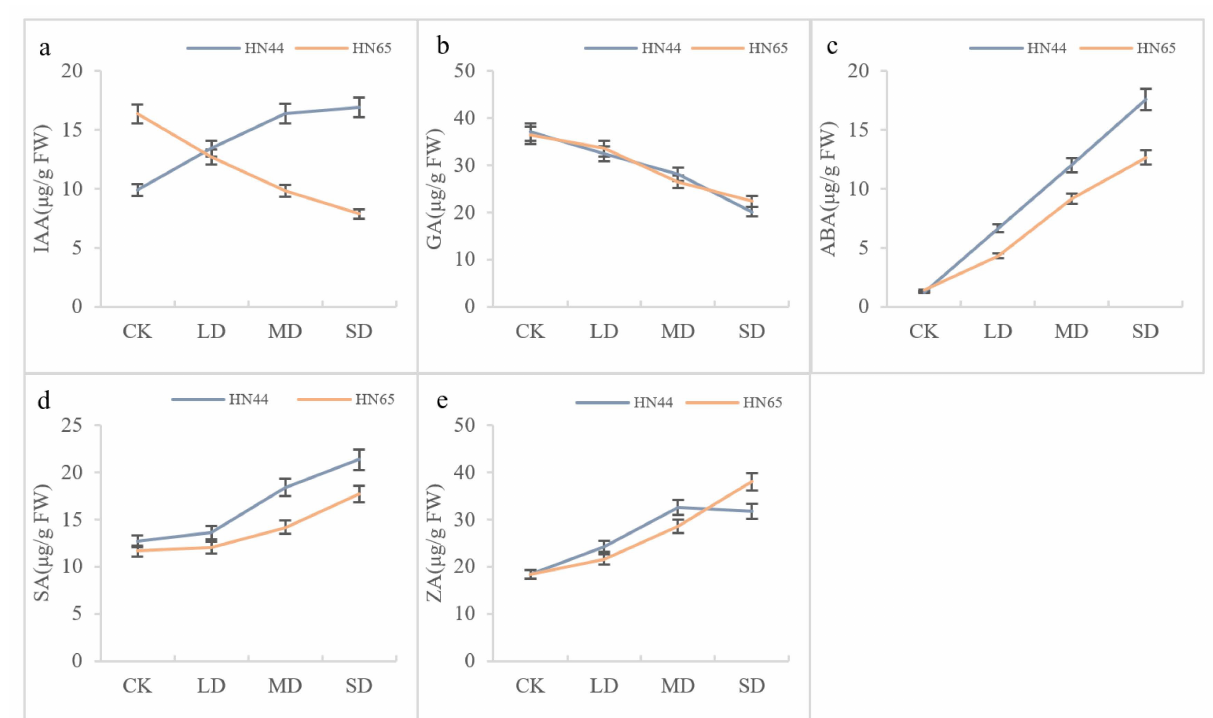
Figure 5. The contents of IAA ( a ), GA ( b ), ABA ( c ), SA ( d ), and ZA ( e ) in HN44 and HN65 under different drought degrees on the 5th day of